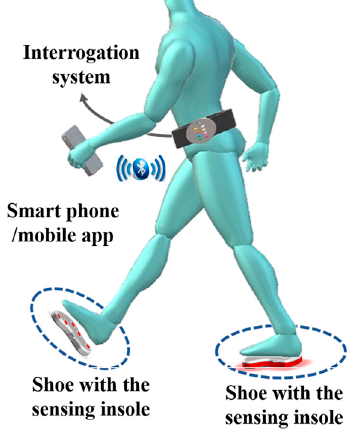
Figure 12. Non-invasive e-Health optical fiber sensing architecture for shear and plantar pressure gait analysis.